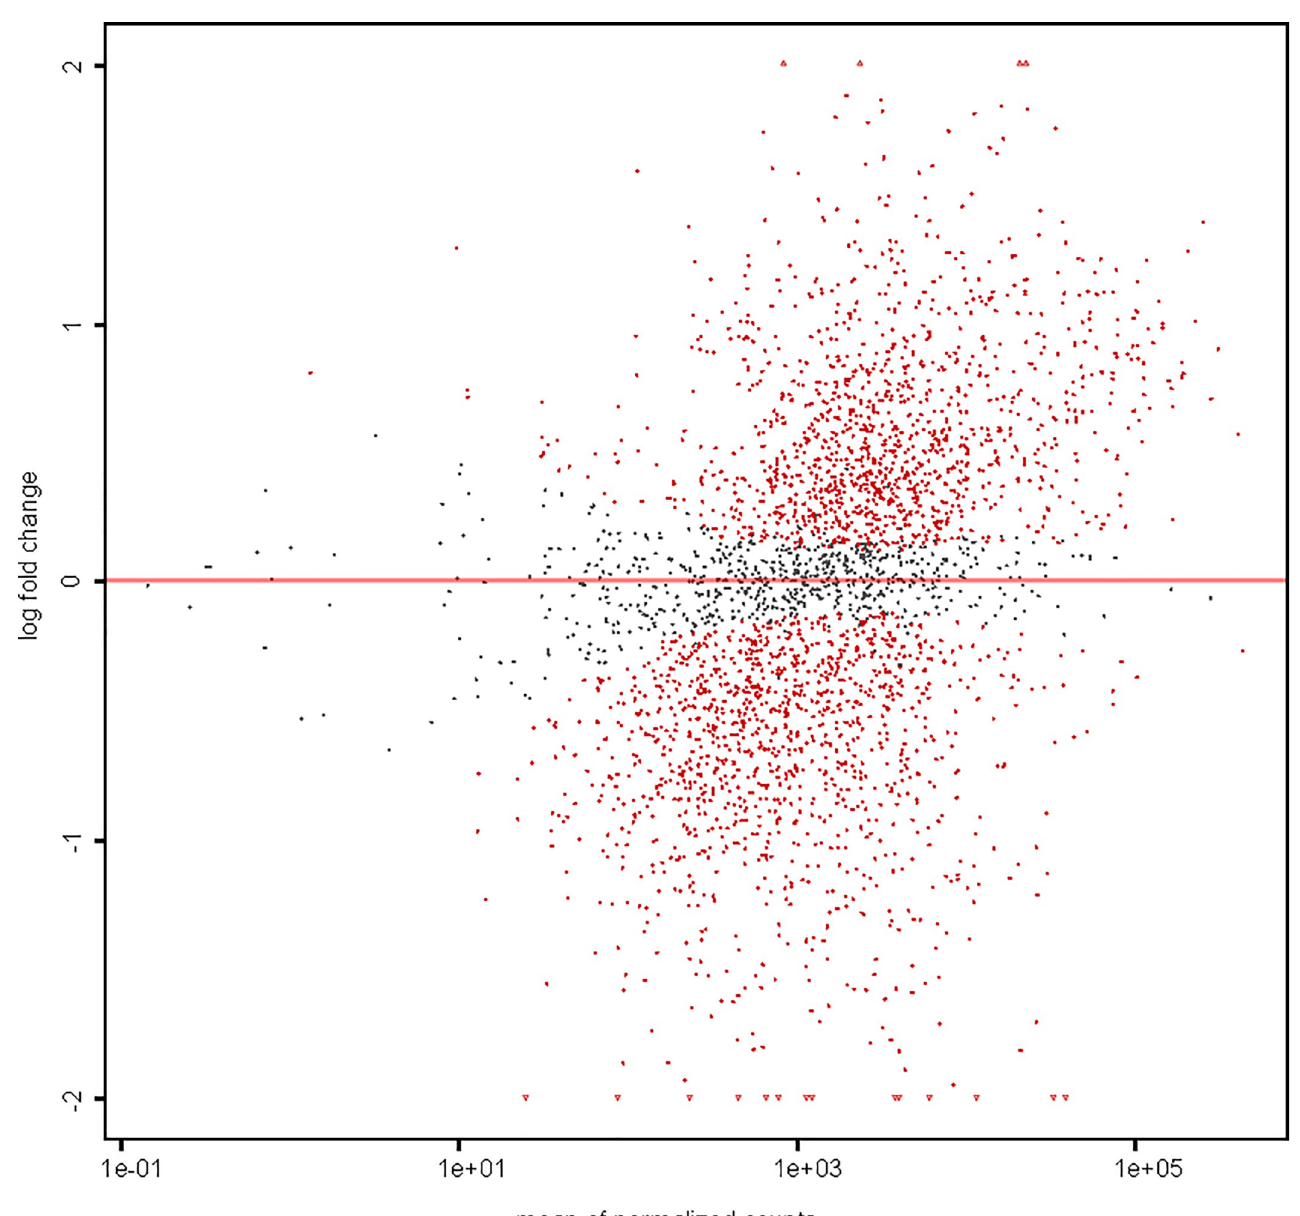
Fig 2. Smear plot of differentially expressed genes (DEGs) in Pdd RM-71 exposed to two temperatures, 15˚C and 25˚C. The smear plot shows the relationship between the log FC and mean of normalized counts. Grey points represent genes with non-significant changes in expression, whereas red points represent genes that are significantly differentially